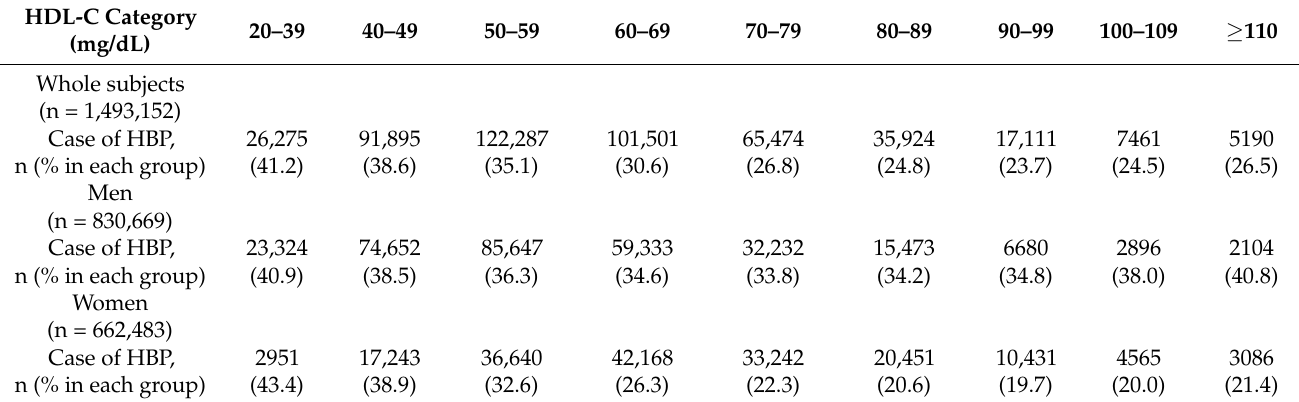
Table 2. Prevalence of HBP according to nine HDL-C concentration categories.